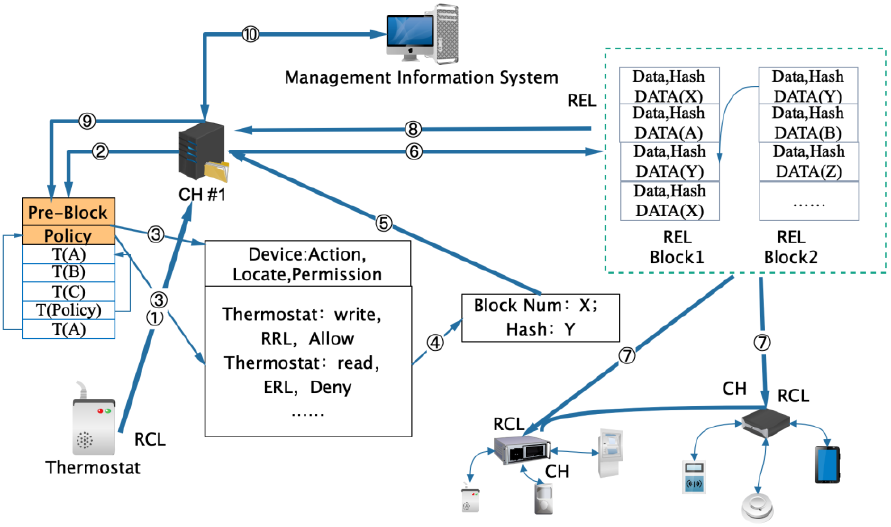
Figure 4. RCL Blockchain generation process for industrial Internet.